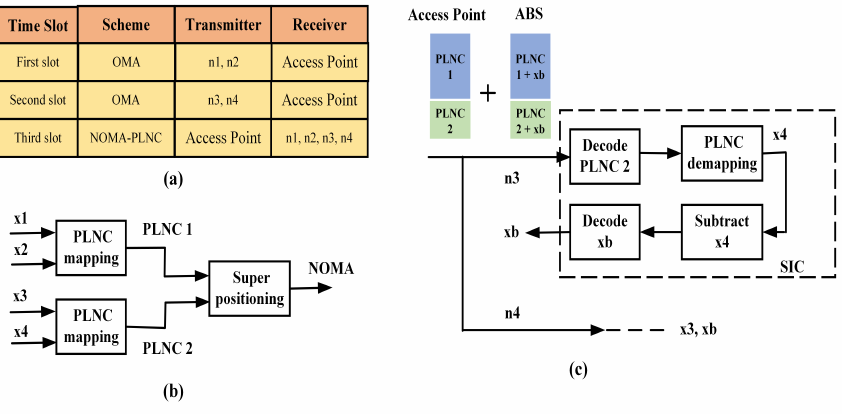
Figure 2. ( a ) Time slot management ( b ) Relay signal detection ( c ) SIC operation at far